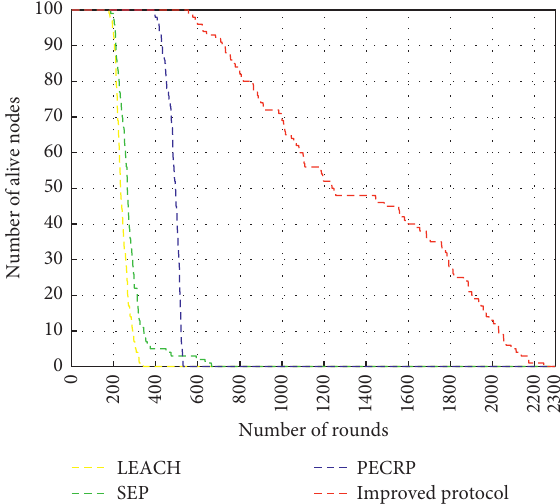
Figure 14: Comparison of live nodes in each round with power